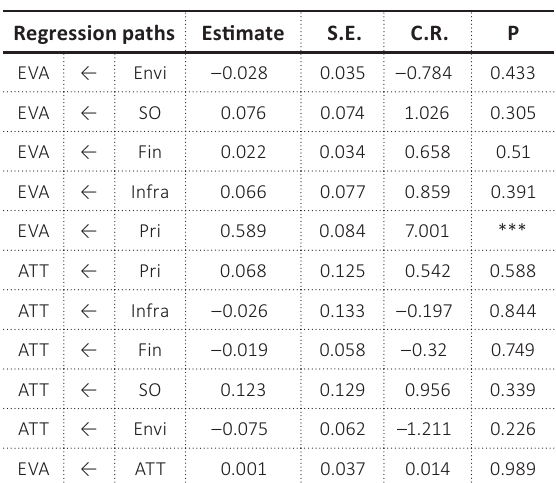
Figure 2. Model Table 6. Regression path coefficients results